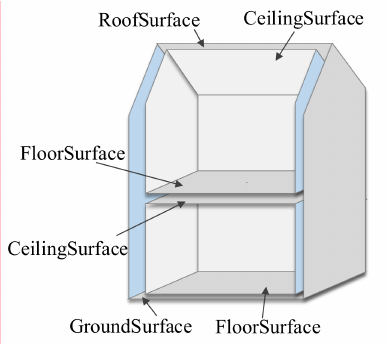
Figure 10. Representation of roofs, ceilings, floors and ground plates in CityGML.